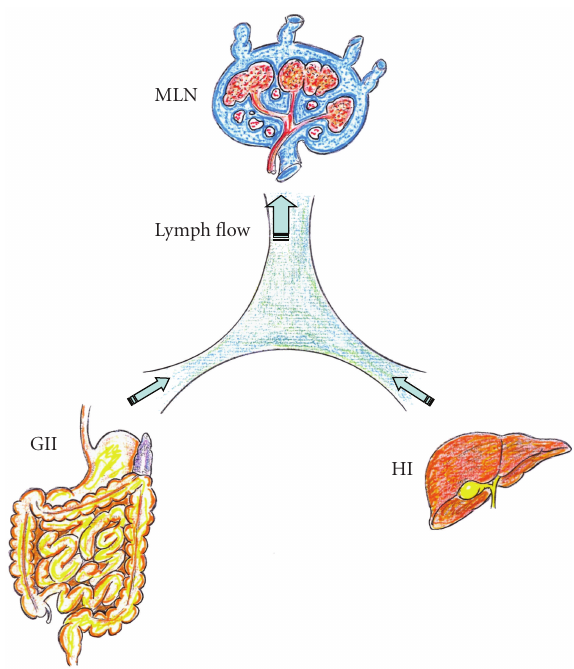
Figure 1: Splanchnic lymphatic flow resulting from the gastroin- testinal interstitium (GII) and the hepatic interstitium (HI) is drained through the mesenteric lymph node (MLN) in physiologi- cal